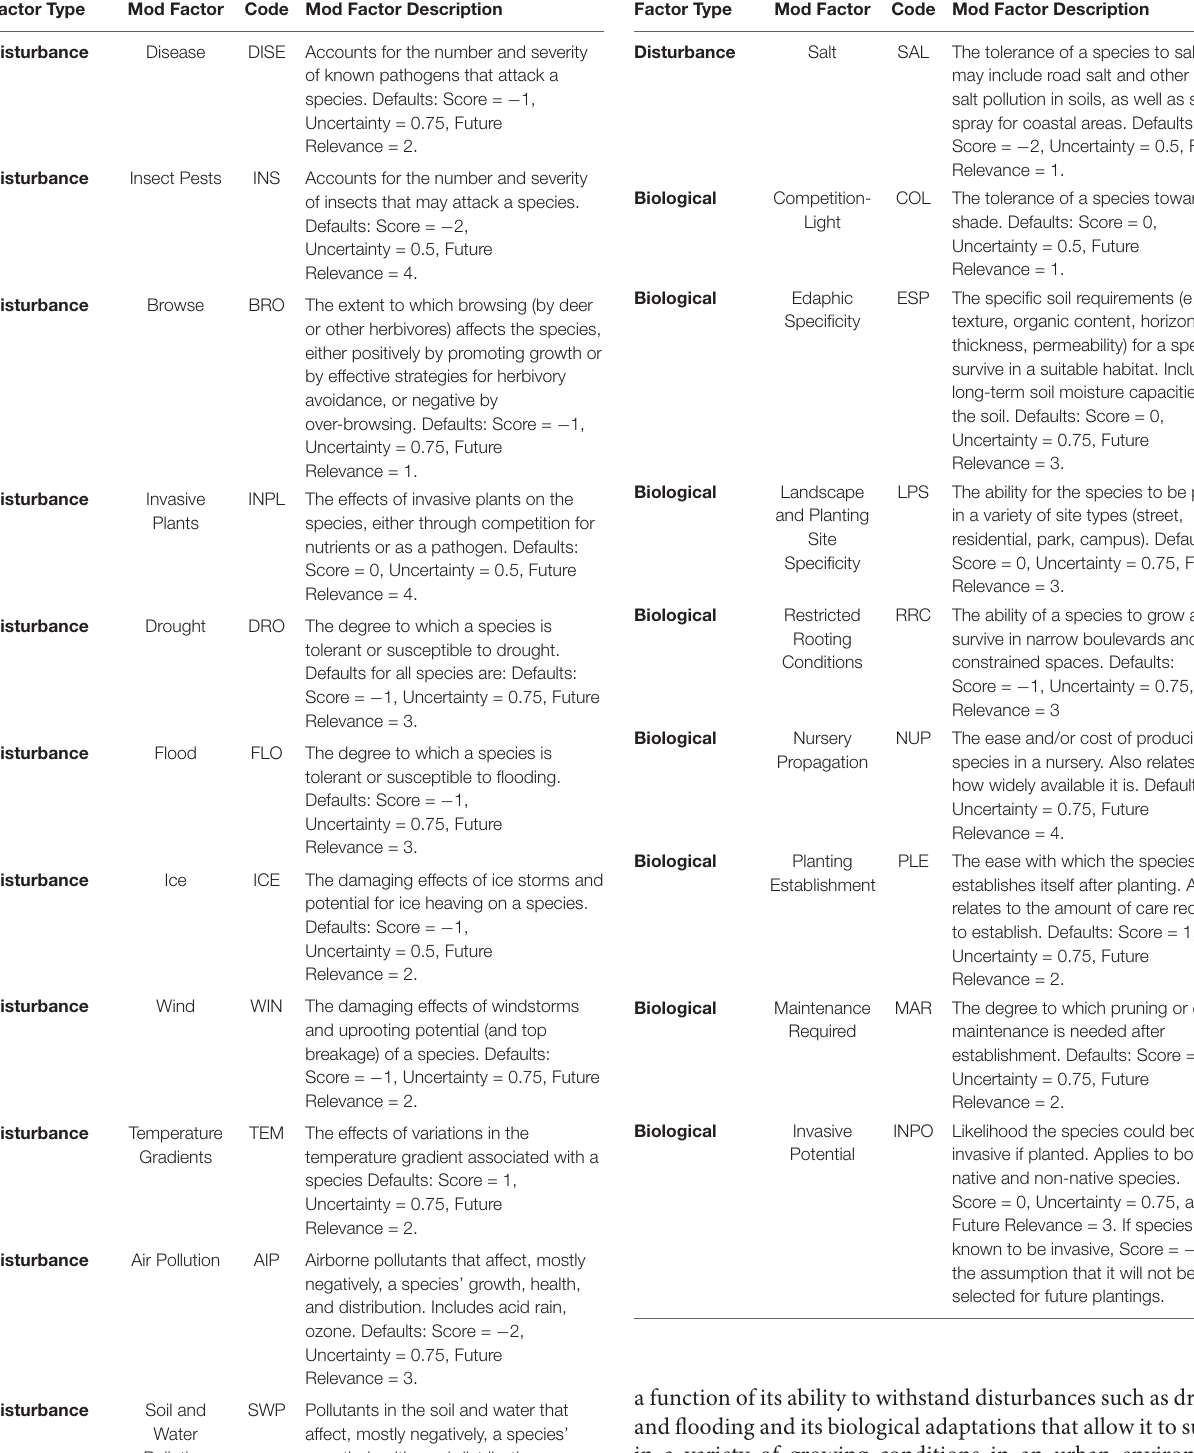
TABLE 2 | Adaptive capacity score factors for trees in planted